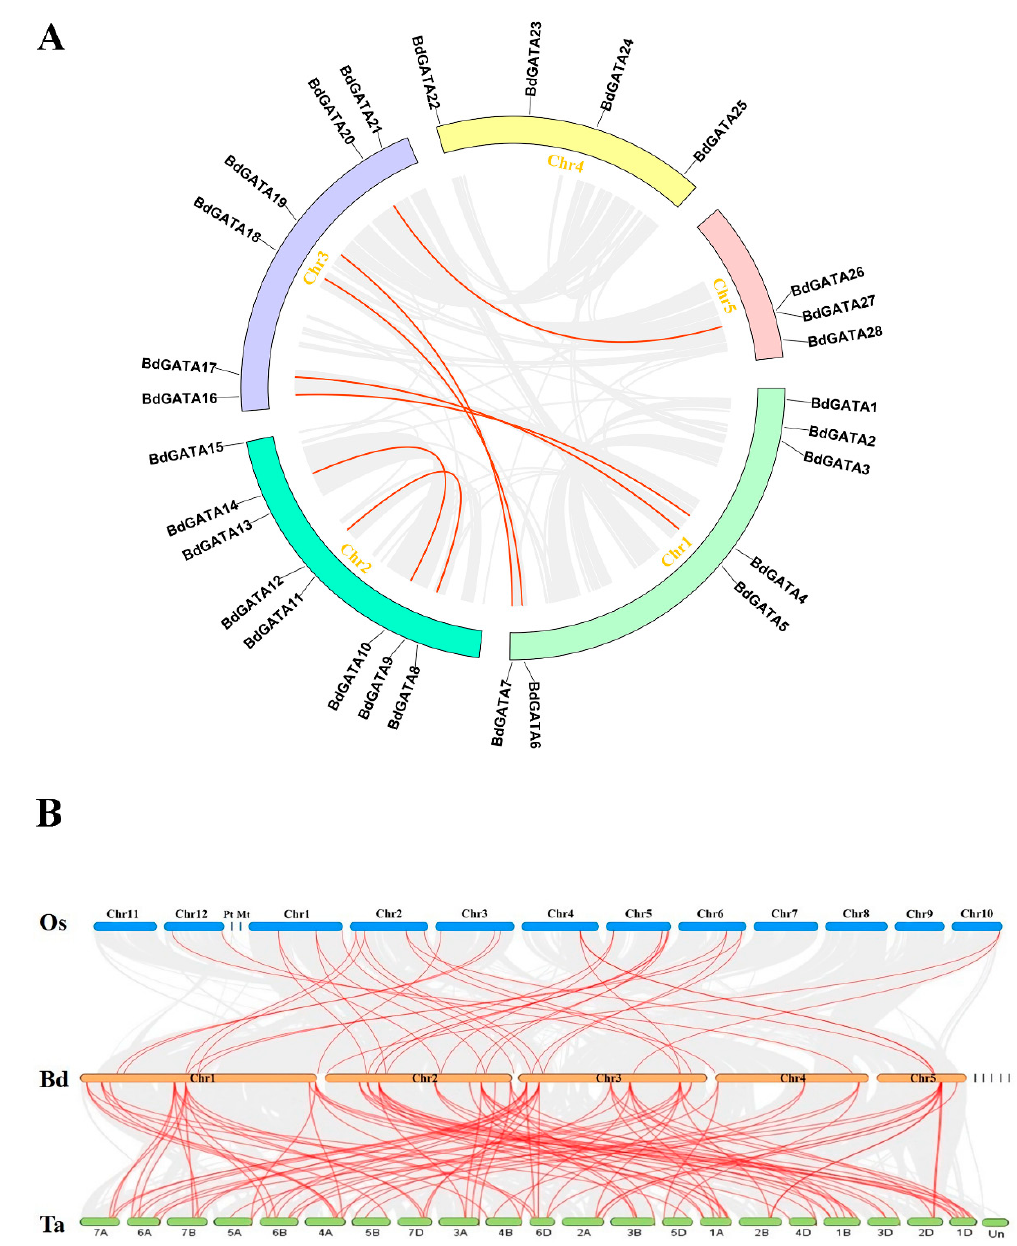
Figure 3. Duplication pairs and synteny analysis of GATA genes between Brachypodium distachyon and rice/wheat. ( A ) Each chromosome is represented with a different color. Gray curves denote the details of syntenic regions in Brachypodium distachyon genome and red curves denote BdGATA gene pairs with segmental duplication. ( B ) Red lines indicate homologous genes between Brachypodium distachyon and rice/wheat chromosomes.